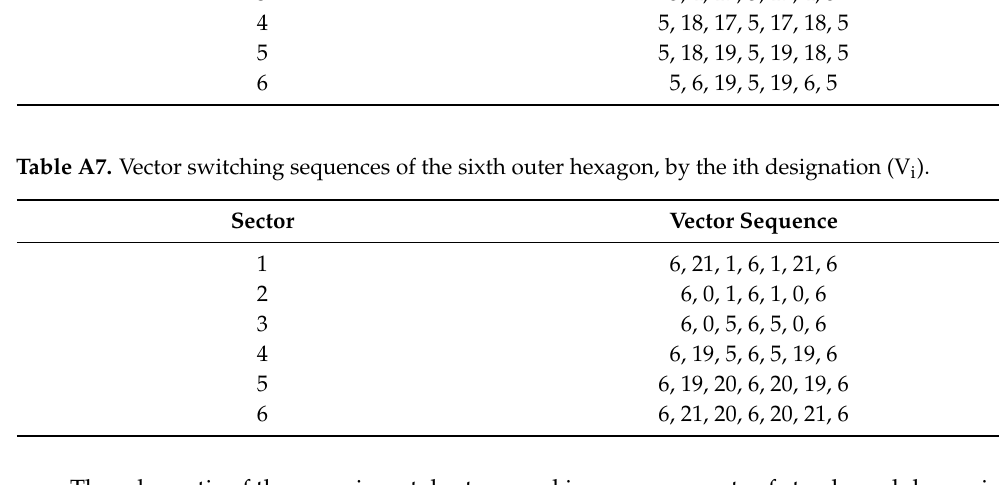
The schematic of the experimental setup used in measurements of steady and dynamic states is presented in Figure A1.